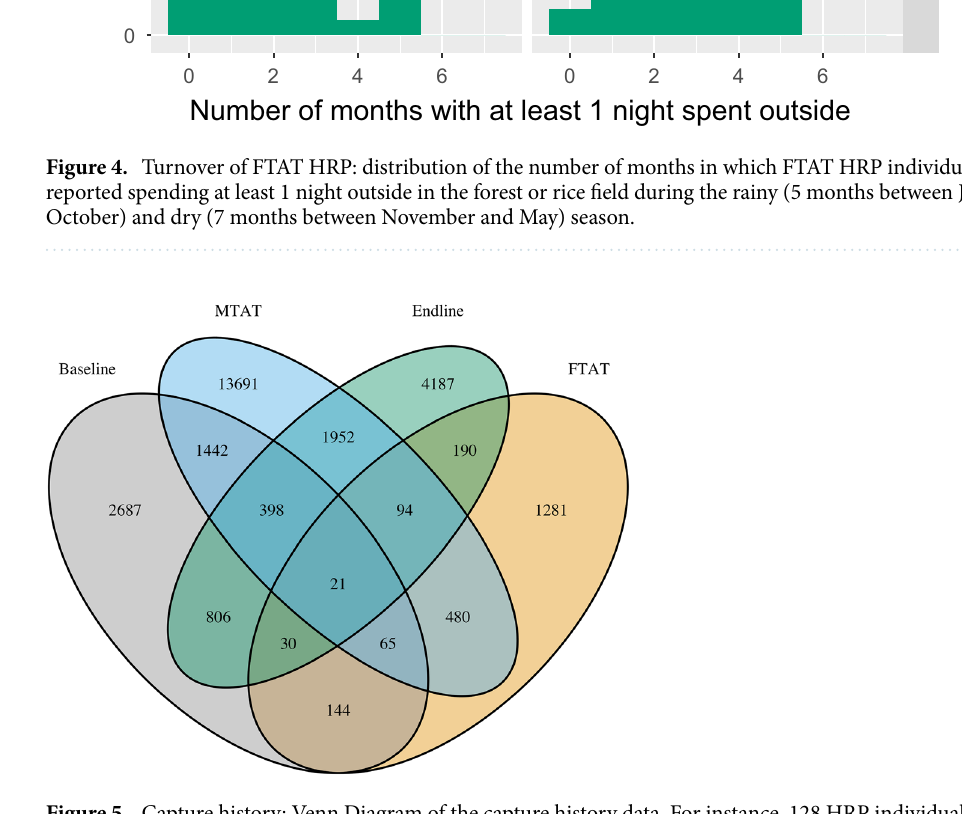
Figure 5. Capture history: Venn Diagram of the capture history data. For instance, 128 HRP individuals were captured both in the MTAT and FTAT surveys but not in baseline or endline